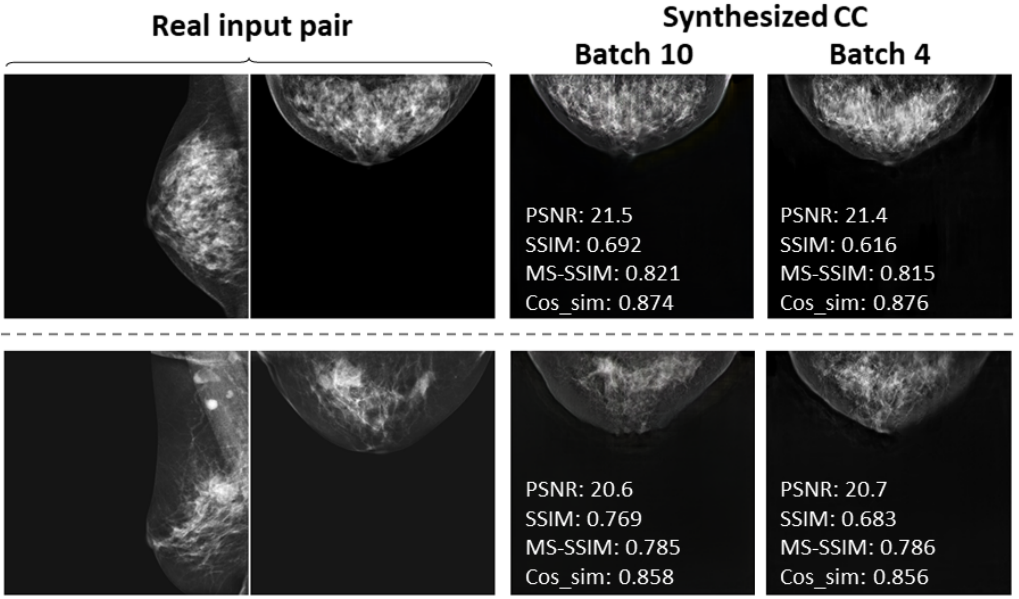
Figure 15. Comparison of examples synthesized CC views at 256 × 256 resolution by batch